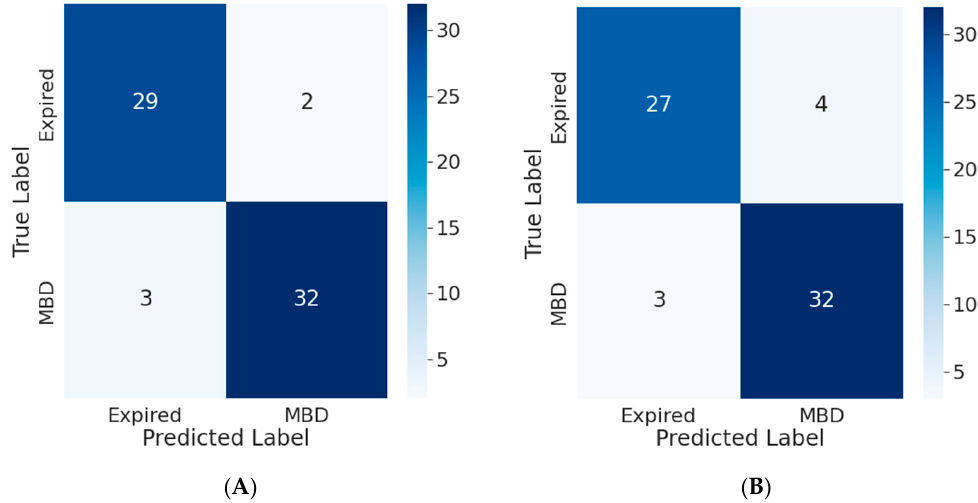
Figure 5. Confusion matrix for transformer model using ( A ) wearable data and ( B ) clinical and wearable data.